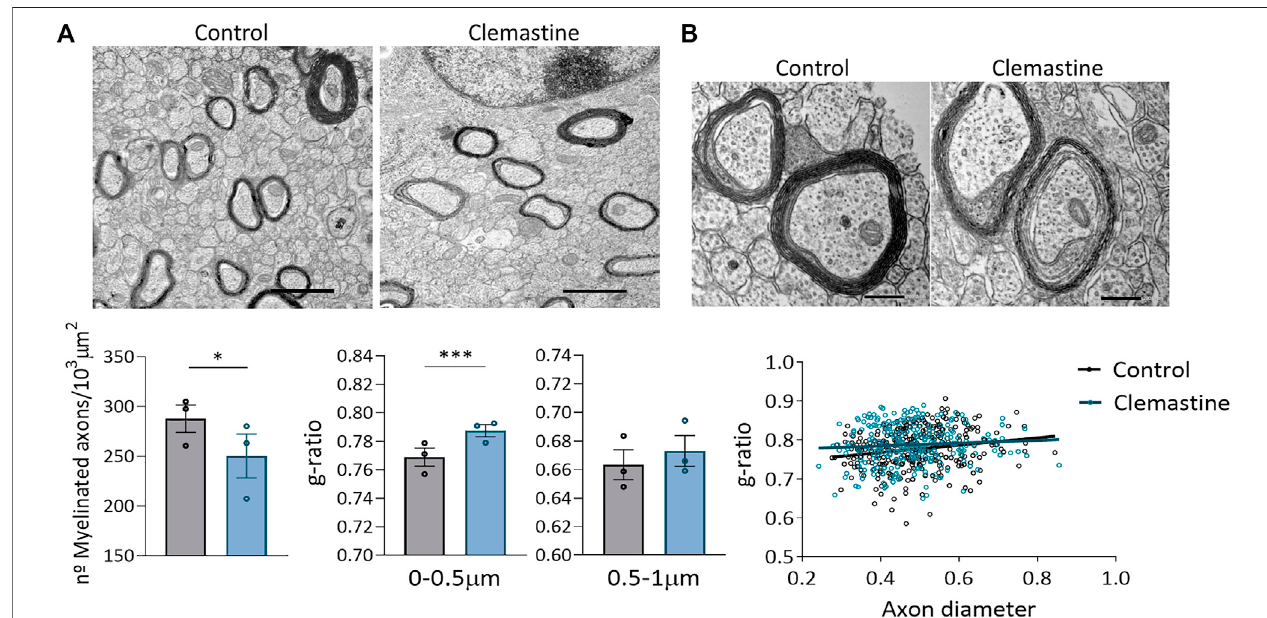
FIGURE 4 |(A) Representative electron microscopy images of myelinated axons within corpus callosum in control and clemastine treated mice. Graphs represent theaverageofmyelinatedaxons(atleast60differentimages per animalfrom n =3mice per group). (B) Representativeelectronmicroscopyimagesofmyelinthicknessin control and clemastine treated mice. Graphs represent the mean g-ratios for small and bigger axons (100-150 axons in control and clemastine-treated mice) and the distribution of g-ratios for control and clemastine-treated mice ( n = 3 mice per group).